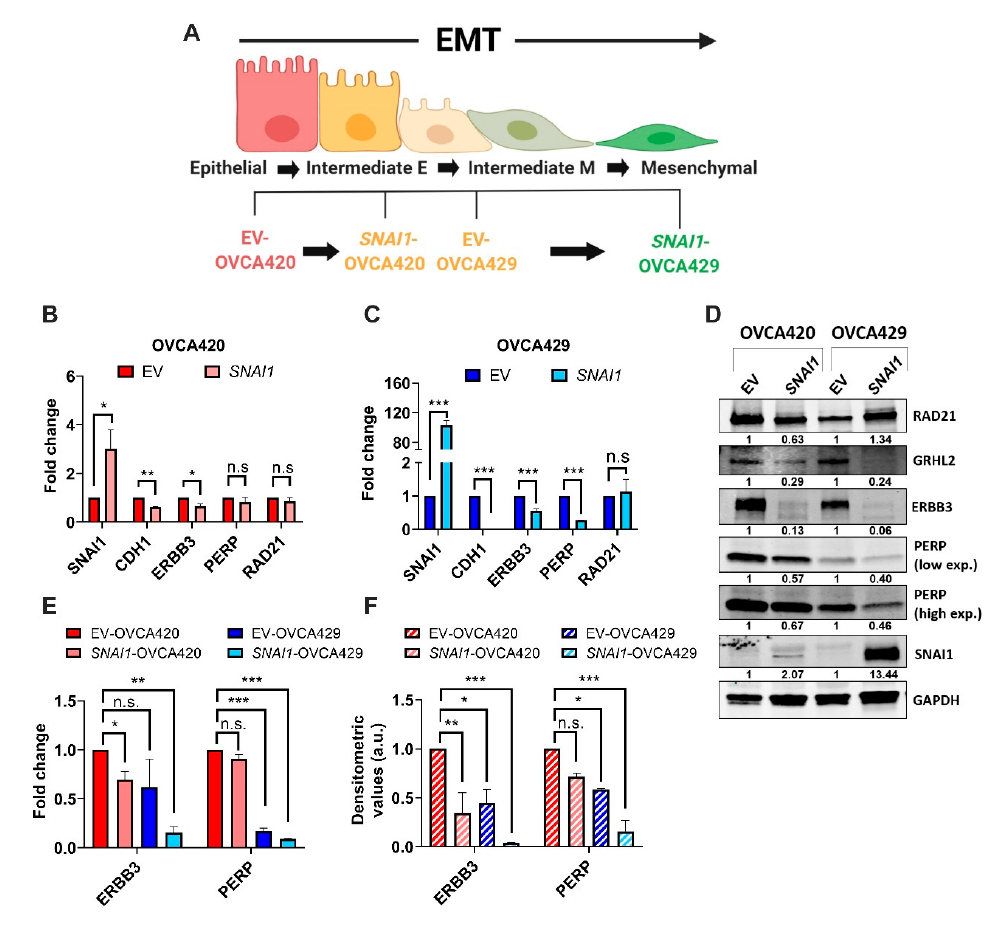
Figure 2. Downregulation of early EMT targets in SNAI1-overexpression cancer cell lines. ( A ) Illustration showing the EMT spectrum model: SNAI1-overexpressing cell lines (SNAI1-OVCA420 and SNAI1-OVCA429 and respective controls EV-OVCA420 and EV-OVCA429). Illustration created with Biorender.com. ( B , C ) Histograms showing the mean mRNA fold changes of indicated genes in SNAI1 -expressing OVCA420 ( B ) and OVCA429 ( C ) relative to the respective control (EV) cells, quantified through RT-qPCR. Mean ± SEM from three independent experiments. Unpaired t -tests were performed; * p < 0.05, ** p < 0.01, and *** p < 0.001; n.s., not significant. ( D ) Immunoblots showing the expression of indicated proteins in the control (EV), SNAI1 -OVCA420, and SNAI1 -OVCA429 cells. Numbers below the gel lanes represent the protein levels, normalized to GAPDH expression and relative to the respective control (EV) cells, determined using ImageJ software. Full-length blots are available in Figure S3 from Supplementary Material. ( E ) Histograms showing the mean mRNA fold changes (from Figure 2 B , C ) of ERBB3 and PERP of the indicated cell lines, normalized to EV-OVCA420 cells. Mean ± SEM from three independent experiments. Unpaired t -tests were performed; * p < 0.05, ** p < 0.01, and *** p < 0.001; n.s., not significant. ( F ) Histograms showing the mean densitometric values of ERBB3 and PERP in indicated cell lines relative to EV-OVCA420 cells, determined using ImageJ software (data from independent duplicates). Mean ± SEM from two independent experiments. Unpaired t -tests were performed to compute the statistical significance; * p < 0.05, ** p < 0.01, and *** p < 0.001; n.s., not significant.